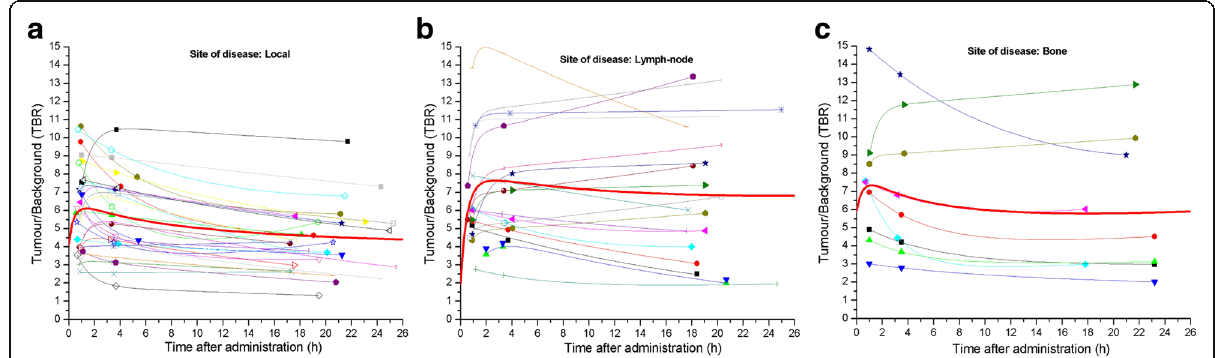
Fig. 5 64 CuCl 2 TBR curves over the time for the three different site of disease: local ( a ), lymph node ( b ) and bone ( c ) (in red the mean curves)